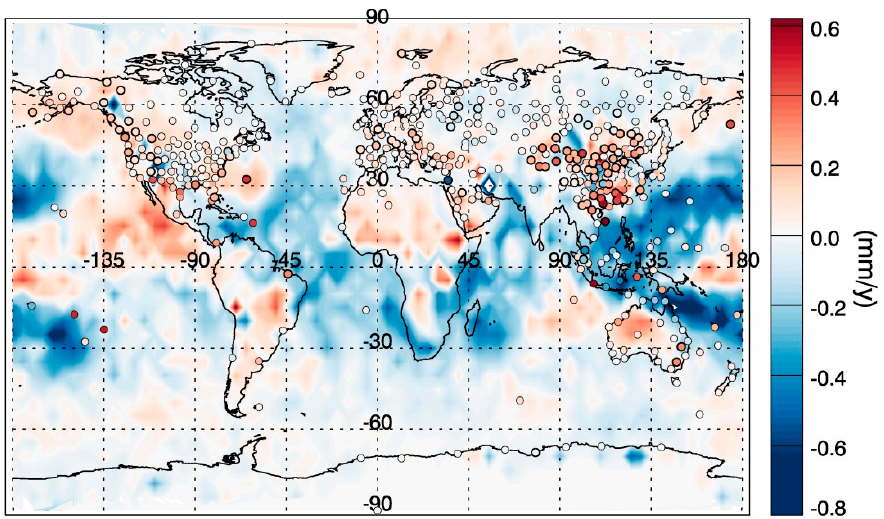
Figure 9. Trends in PW from IGRA and COSMIC for the period of 2007–2016 (stations with bold black circles are stations with significant trends).